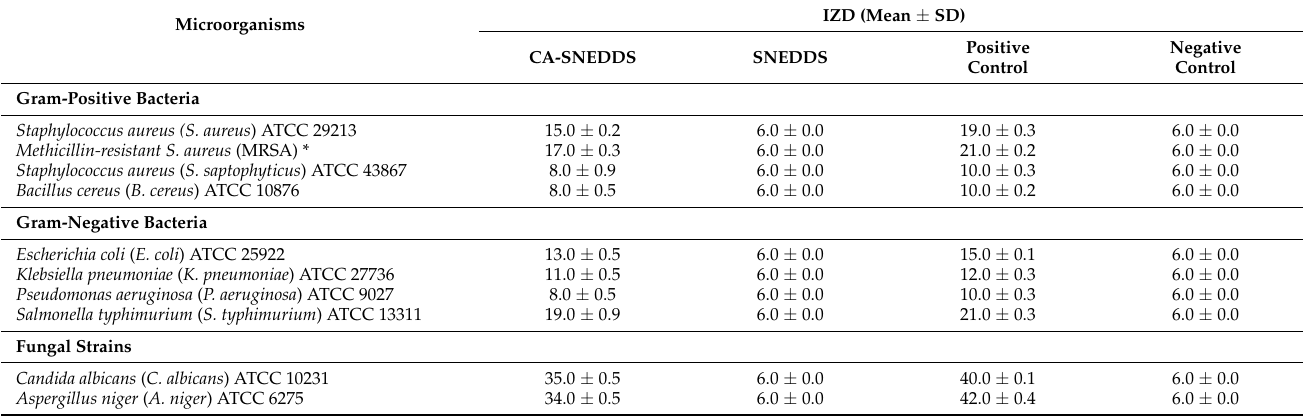
Table 1. Preliminary antimicrobial activity of